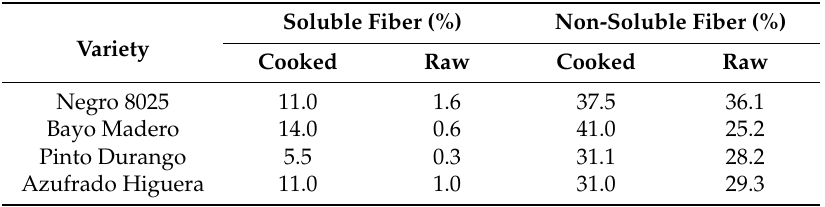
Table 4. Soluble and non-soluble fiber content on the Mexican bean varieties in their cooked and raw forms.